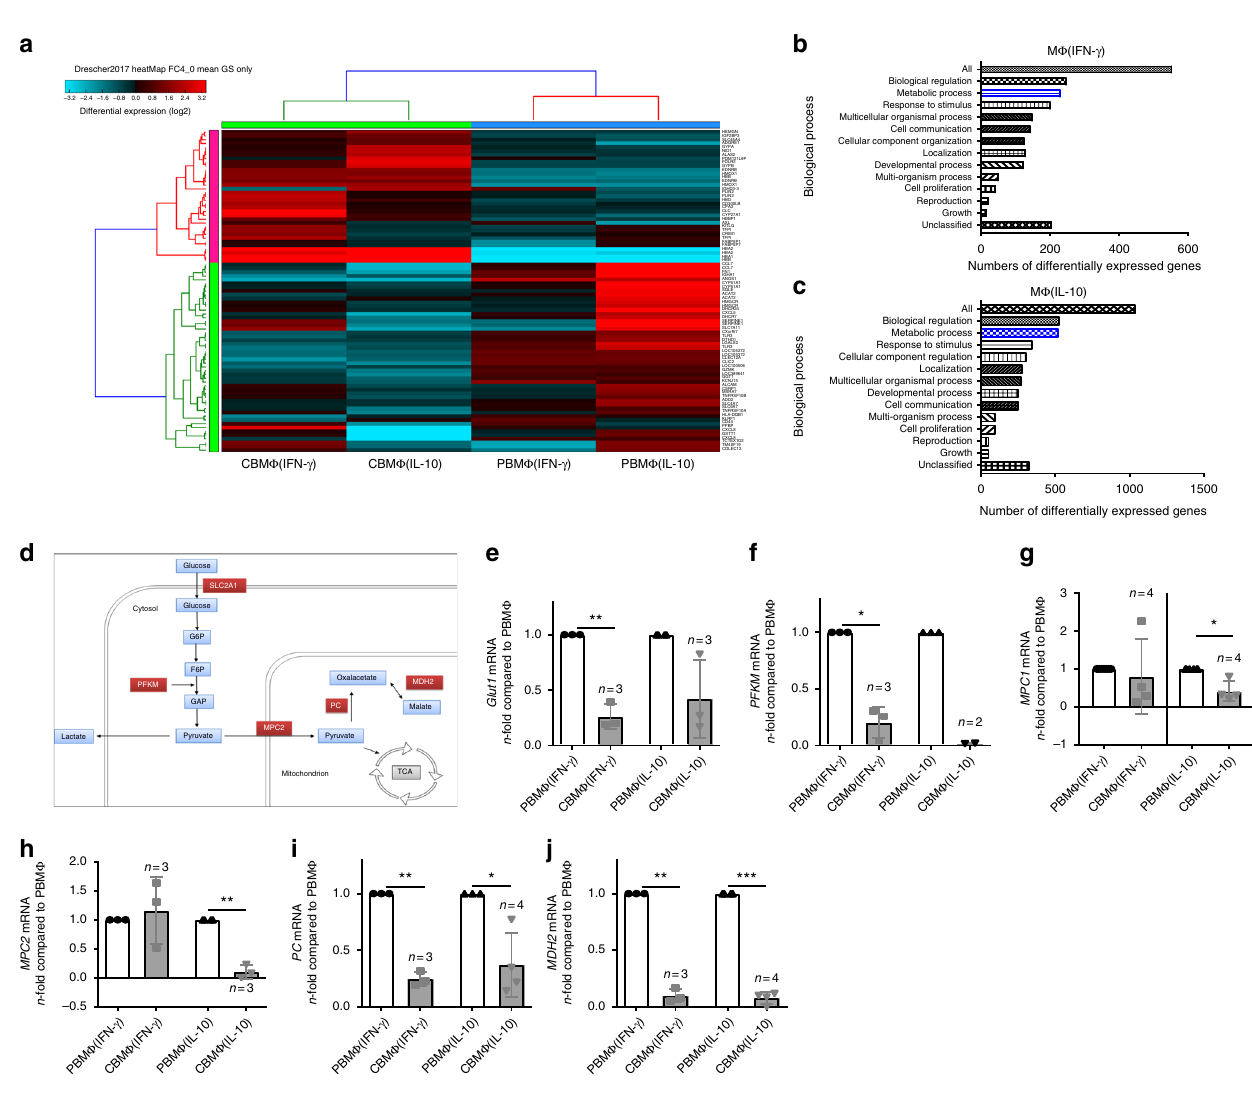
Fig. 2 Whole-transcriptome analysis reveals broad metabolic aberrations in polarized cord blood macrophages. a Heatmap of differently expressed genes between CBM Φ and PBM Φ after polarization (FC > 4). b , c Enrichment analysis for the top enrichment GO terms from the biological process is shown for M Φ (IFN- γ ) ( b ) and for M Φ (IL-10) ( c ), metabolic processes are highlighted in blue. d Schematic picture of metabolic enzymes that are downregulated in CBM Φ (in red) in glucose metabolism. e – j N-fold mRNA expression of metabolic enzymes in CBM Φ (IFN- γ ) and CBM Φ (IL-10) compared with means of PBM Φ (IFN- γ ) and PBM Φ (IL-10) analyzed by RT-qPCR. e Glut1 mRNA expression was measured in n = 3 PBM Φ (IFN- γ ), 3 CBM Φ (IFN- γ ), 4 PBM Φ (IL-10), and 3 CBM Φ (IL-10) independent samples, ** p -value = 0.0078. f PFKM mRNA expression was measured in n = 3 PBM Φ (IFN- γ ), 3 CBM Φ (IFN- γ ), 3 PBM Φ (IL-10), and 2 CBM Φ (IL-10) independent samples, * p -value = 0.0101. g MPC1 mRNA expression was measured in n = 7 PBM Φ (IFN- γ ), 4 CBM Φ (IFN- γ ), 6 PBM Φ (IL-10), and 4 CBM Φ (IL-10) independent samples, * p -value = 0.0213. h MPC2 mRNA expression was measured in n = 3 PBM Φ (IFN- γ ), 3 CBM Φ (IFN- γ ), 4 PBM Φ (IL-10), and 3 CBM Φ (IL-10) independent samples, ** p -value = 0.0056. i PC mRNA expression was measured in n = 3 PBM Φ (IFN- γ ), 3 CBM Φ (IFN- γ ), 3 PBM Φ (IL-10), and 4 CBM Φ (IL-10) independent samples, * p -value = 0.0208 and ** p -value = 0.0023. j MDH2 mRNA expression was measured in n = 3 PBM Φ (IFN- γ ), 3 CBM Φ (IFN- γ ), 4 PBM Φ (IL-10), and 4 CBM Φ (IL-10) independent samples, ** p -value = 0.0014 and *** p -value < 0.0001. For ( e – j ), bars indicate mean and error bars SD, two-tailed, one-sample